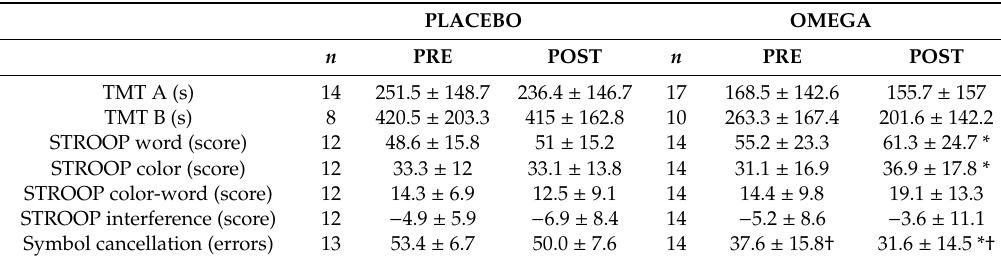
Table 3. Trail Making Tests (TMT), Stroop Color and Word (STROOP) tests, and cancellation tests at pre and post (6mo) of placebo or omega supplementation.